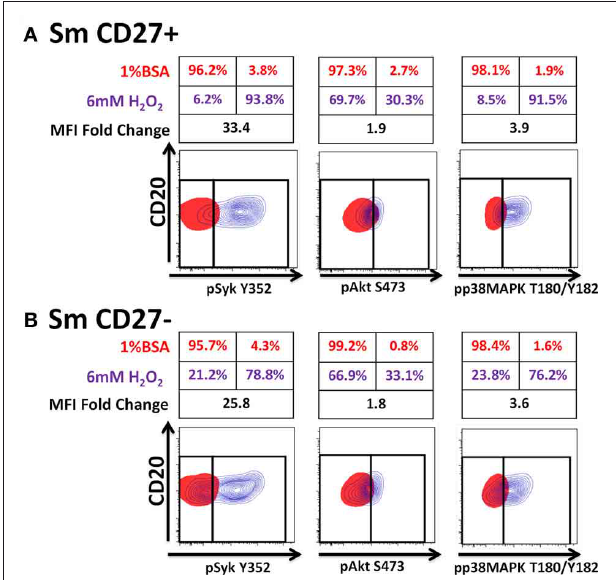
FIGURE 8 | Phosphatases in Sm CD27 + and Sm CD27 − B cells are similarly susceptible to inhibition by H 2 O 2 . PBMC were treated with 6mM of H 2 O 2 phosphorylation of proteins associated with the BCR were detected in both, naïve and Um B cells ( A and B ) after 5min stimulation at 37 ◦ C. Displayed are overlaps of unstimulated (1% BSA) (red) and 6mM of H 2 O 2 stimulated (without anti-IgM) (purple) naïve and Um B-cells. Percentage as well as fold changes in MFI (as compared to unstimulated) are shown. Um cells showed enhanced phosphorylation of Syk and p38MAPK (B) , compared to naïve B cells (A) . Akt phosphorylation was similar in both cell populations ( A and B